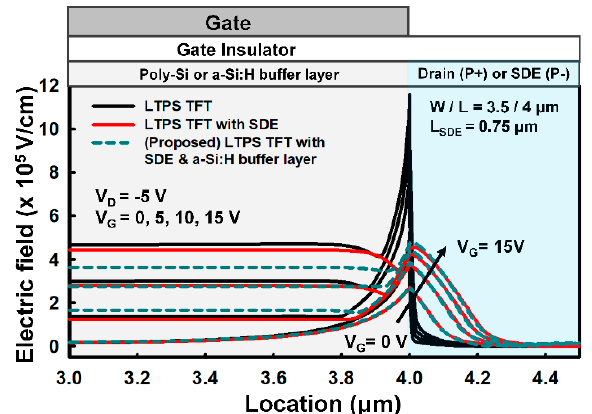
Figure 4. Linear scale (left Y -axis) and log scale (right Y -axis) transfer ( I D - V G ) curves of a conventional LTPS TFT, LTPS TFT with SDE, and the proposed LTPS TFT with SDE and amorphous silicon buffer layer: ( a ) at V D = − 5 V; and ( b ) at V D = − 1 V. The blue (red) background are the areas where the thermal (field-enhanced) generation mechanism is dominant.